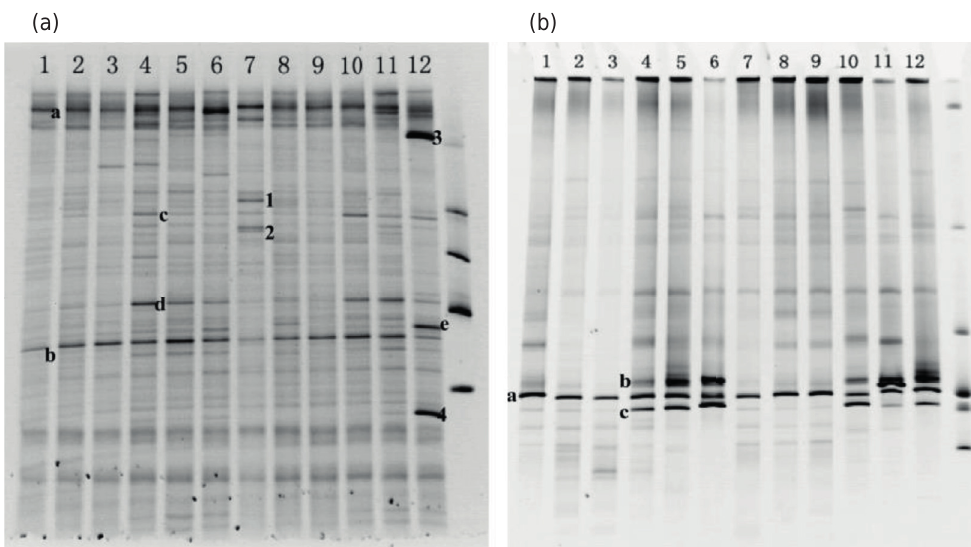
Figure 1. Denaturing gradient gel electrophoresis (DGGE) analyses of 16S rDNA fragments for bacteria (a) and 18S rDNA fragments for fungi (b) in different treatments. 1: unplanted treatment with ambient CO 2 and well-watered condition; 2: unplanted treatment with ambient CO 2 and mild drought condition; 3: unplanted treatment with ambient CO 2 and severe drought condition; 4: planted treatment with ambient CO 2 and well-watered condition; 5: planted treatment with ambient CO 2 and mild drought condition; 6: planted treatment with ambient CO 2 and severe drought condition; 7: unplanted treatment with elevated CO 2 and well-watered condition; 8: unplanted treatment with elevated CO 2 and mild drought condition; 9: unplanted treatment with elevated CO 2 and severe drought condition; 10: planted treatment with elevated CO 2 and well-watered condition; 11: planted treatment with elevated CO 2 and mild drought condition; and 12: planted treatment with elevated CO 2 and severe drought condition.